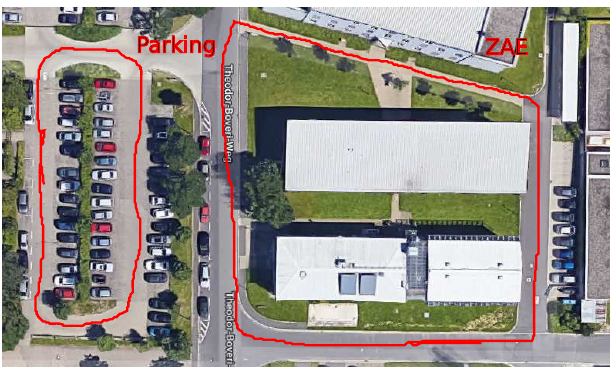
Figure 4. The corresponding satellite images for the Bavarian Center for Applied Energy Research (ZAE) and parking lot data sets. Red curves are the trajectories the robot traveled [40]. To improve the accuracy of the 3D point cloud, we combined the trajectories from HectorSLAM and GPS by applying our curvefusion approach. Note that the outputs of both HectorSLAM and curvefusion are 2D trajectories. In the first part of the experiments, the results of HectorSLAM and curvefusion were used to “unwind” the data of the Riegl VZ-400. Some intuitive 3D point cloud displays are presented, which will show that our curvefusion outperforms